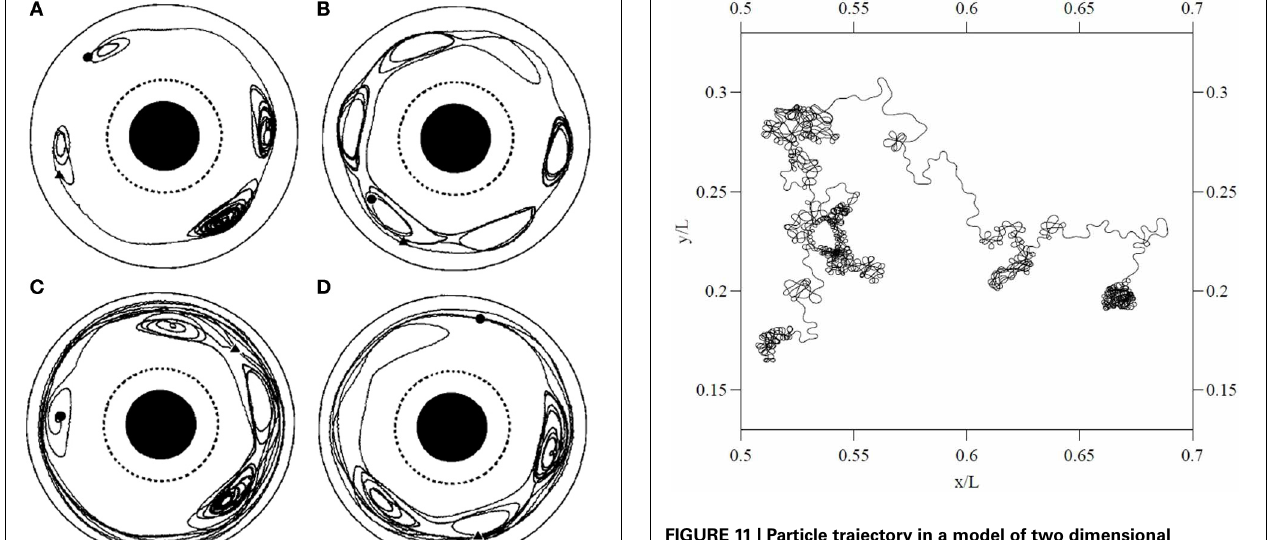
FIGURE 11 | Particle trajectory in a model of two dimensional magnetic turbulent flow. From Chiaravalloti et al. (2006), copyright the Royal Swedish Academy of Sciences 2006. Reproduced by permission of IOP